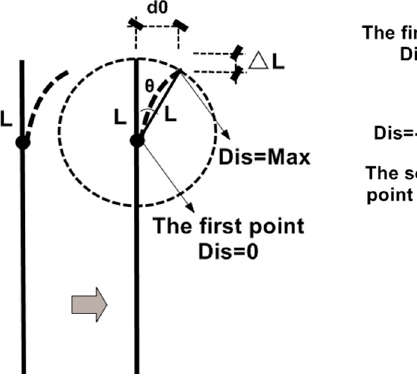
( b ) Figure 7. ( a ) Load–displacement of pile cap, and ( b ) variation in symmetric batter pile group effi- ciency with pile spacing. The pile group effect is defined in Equation (5), where UV nD and UV single represent the loads of the symmetrical and single batter pile under the same displacement, respectively (below the failure load), and n is the number of piles in the pile group, which equals 2 in this paper. The lower the coefficient, the more significant the pile group effect. The results are shown in Figure 8b.